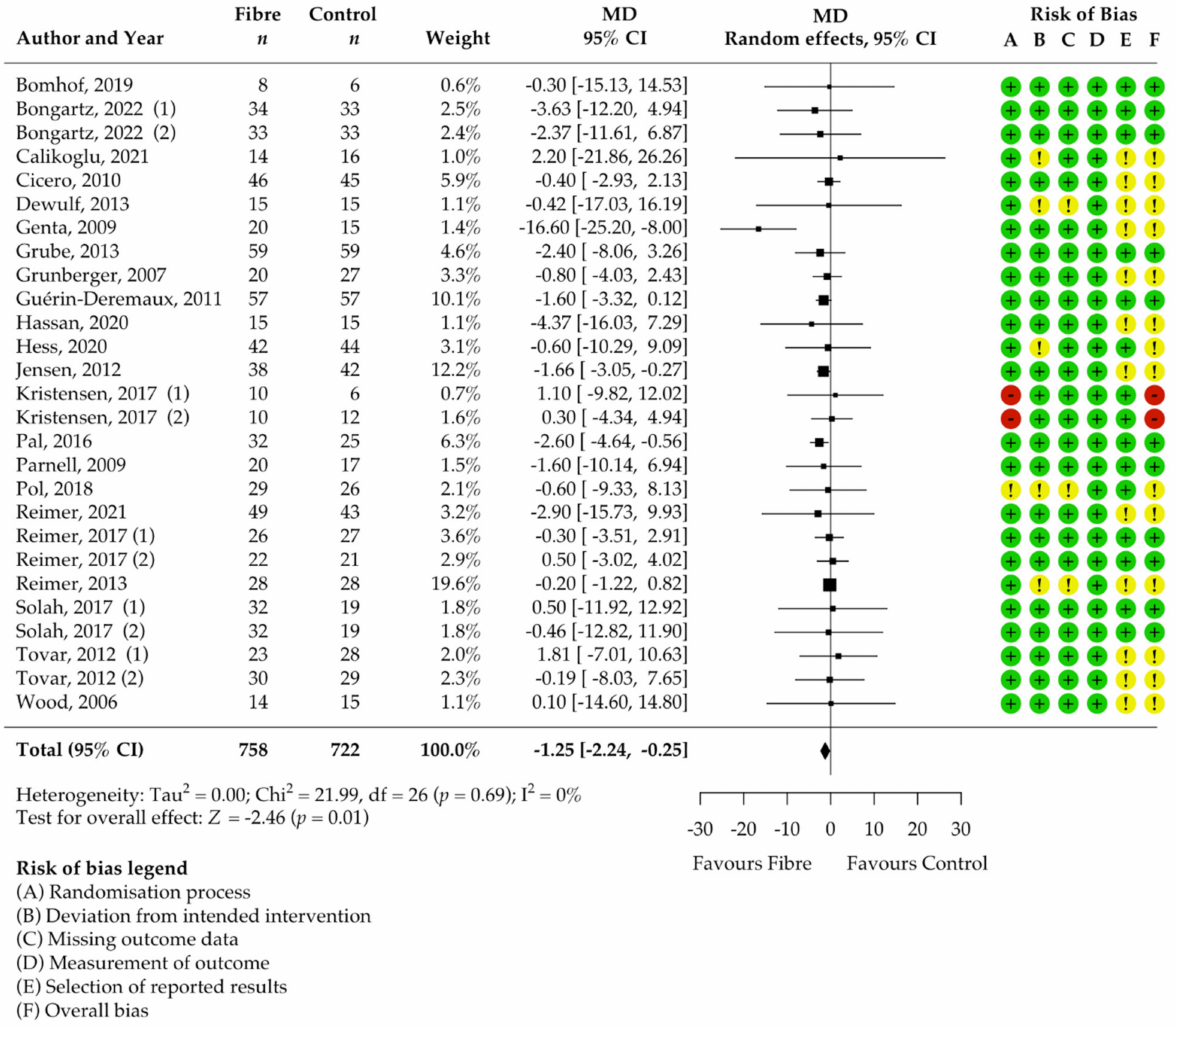
Figure 3. Isolated soluble dietary fibre supplementation significantly decreased body weight [kg] in overweight and obese people ( n = 1428). Black rectangles represent MD for each study; the size of the rectangle is proportional to the weight of the study for the pooled effect. Horizontal lines indicate 95% CI. The black diamond summarises the pooled MD data. MD = mean difference; (1)/(2) indicate cohort 1 and 2 of study